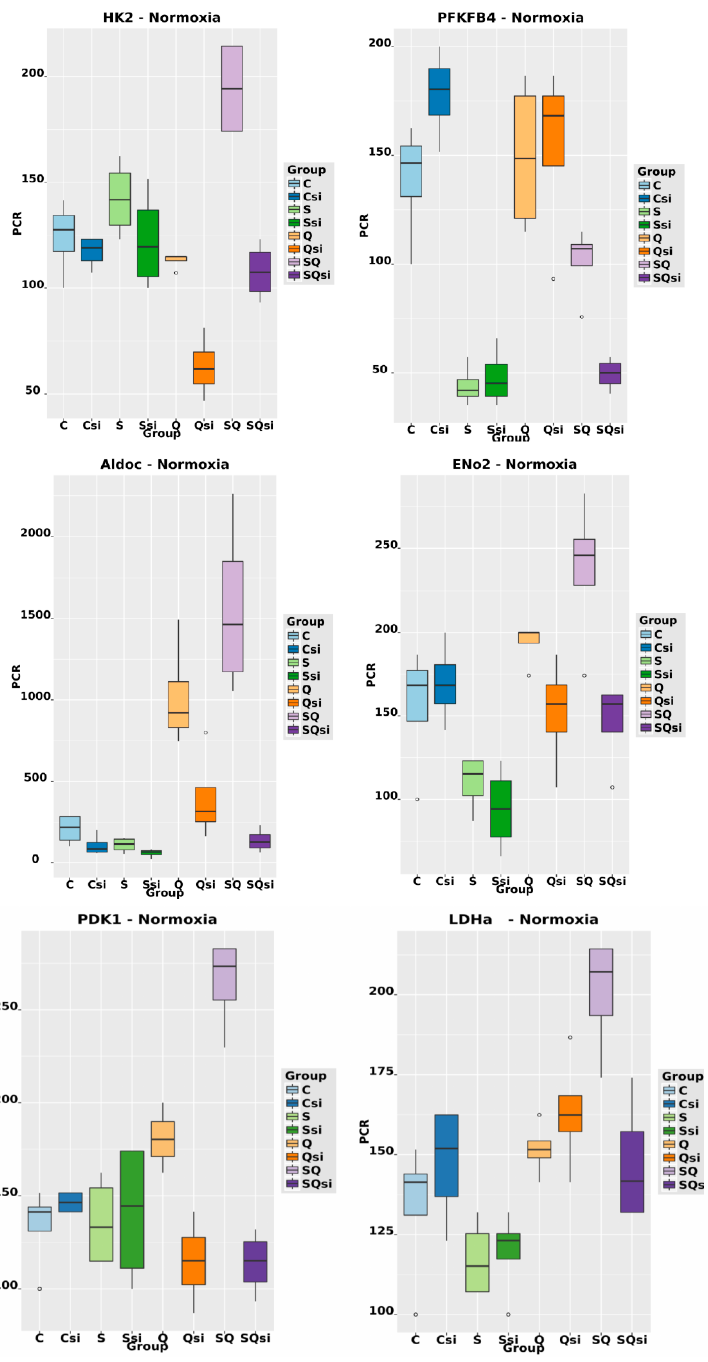
Figure 9. Relative mRNA levels of HK2, PFKFB4, ALDOC, ENO2, PDK1, and LDHA normalized each to the RPL9 mRNA level, after the application of 5 mM L-glutamine (Q) corresponding to Figure 1 (lanes 5–8), 1% fetal bovine serum (S) (lanes 3, 4, 7, and 8) and / or 5 nM HIF1 α -specific siRNA (si) (lanes 2, 4, 6, and 8) or medium without glutamine, serum and siRNA (c -control) lane 1 under normoxic conditions in the MDA-MB-231 cells 24 h after the start of the treatment. The transcription of these genes was significantly regulated by HIF1 under normoxic conditions due to the stabilization of HIF1 α via glutamine and fetal bovine serum. (For p -values, please refer to Supplemental Tables S1 and S2; see also Supplemental Figure